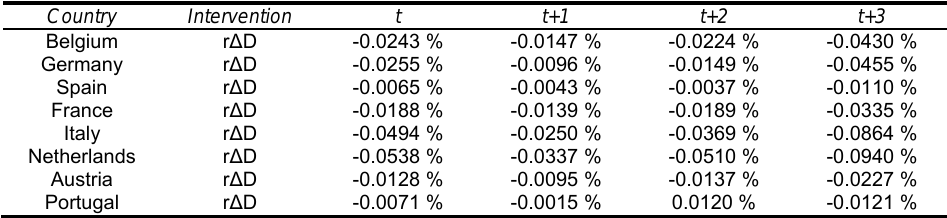
Table 16. The additional interest payments when no corrections are made, using the constant slope